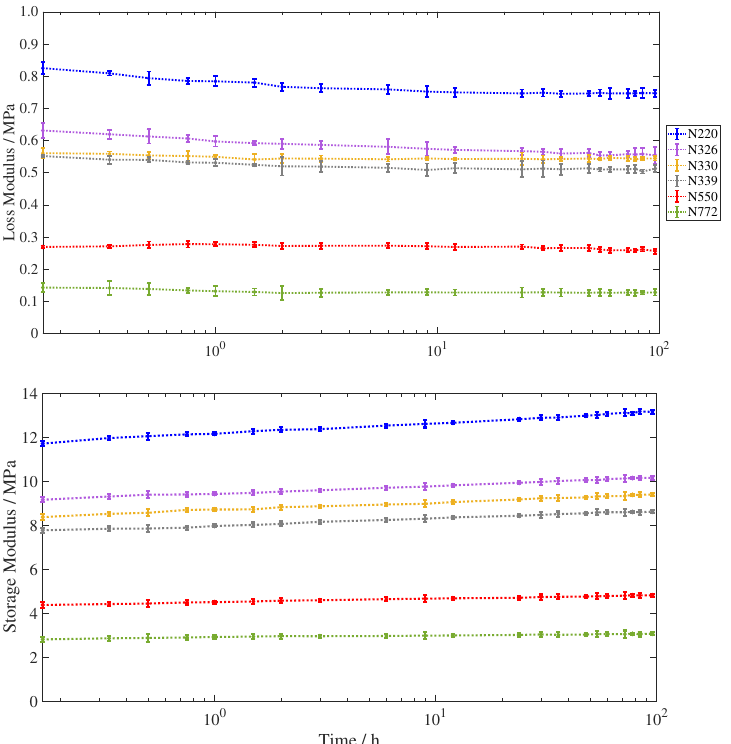
Figure 5. Evolution of the loss (top) and storage (bottom) modulus from 10 min to 96 h after a temperature drop from 70 to 30 ◦ C. The different carbon black types are plotted in blue (N220), purple (N326), yellow (N330), grey (N339), red (N550), and green